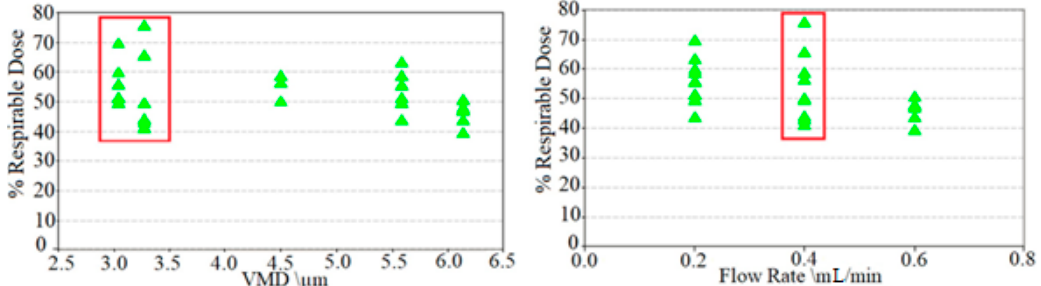
Figure 2. Volume median diameter (VMD) and volume flow rates of the Dance 501 collected distal to the Alberta throat with a simulate inspiratory flow rate of 10 L.m − 1 . The VMD is sufficient; however, the flow rate is inadequate and required multiple breaths and breathing techniques to administer a dose. The volume median diameter (VMD) to percentage respirable dose (%RD) of the Dance 501. Statistical analysis was carried out using SPSS 20.0 software (IBM, Armonk NY, USA). ANOVA,